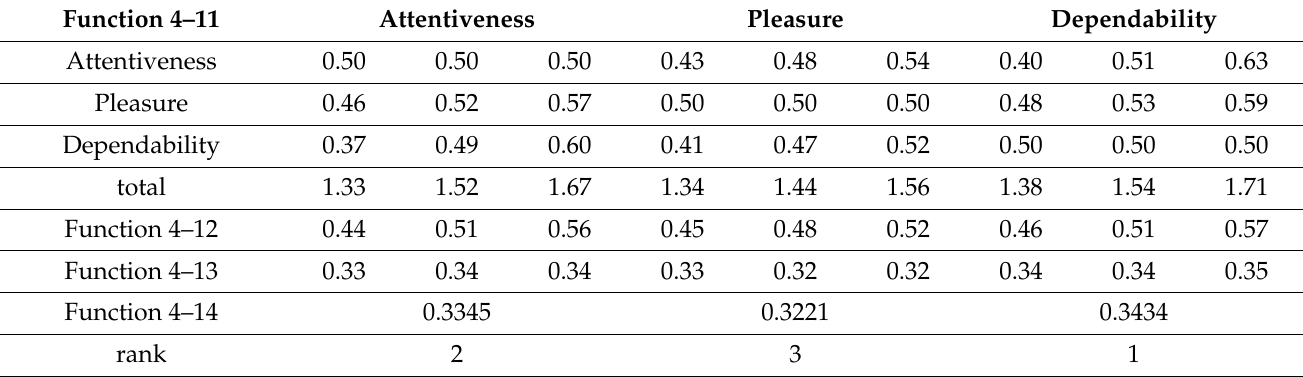
Table A12. Travel agencies’ weights of attributes of the emotional value.